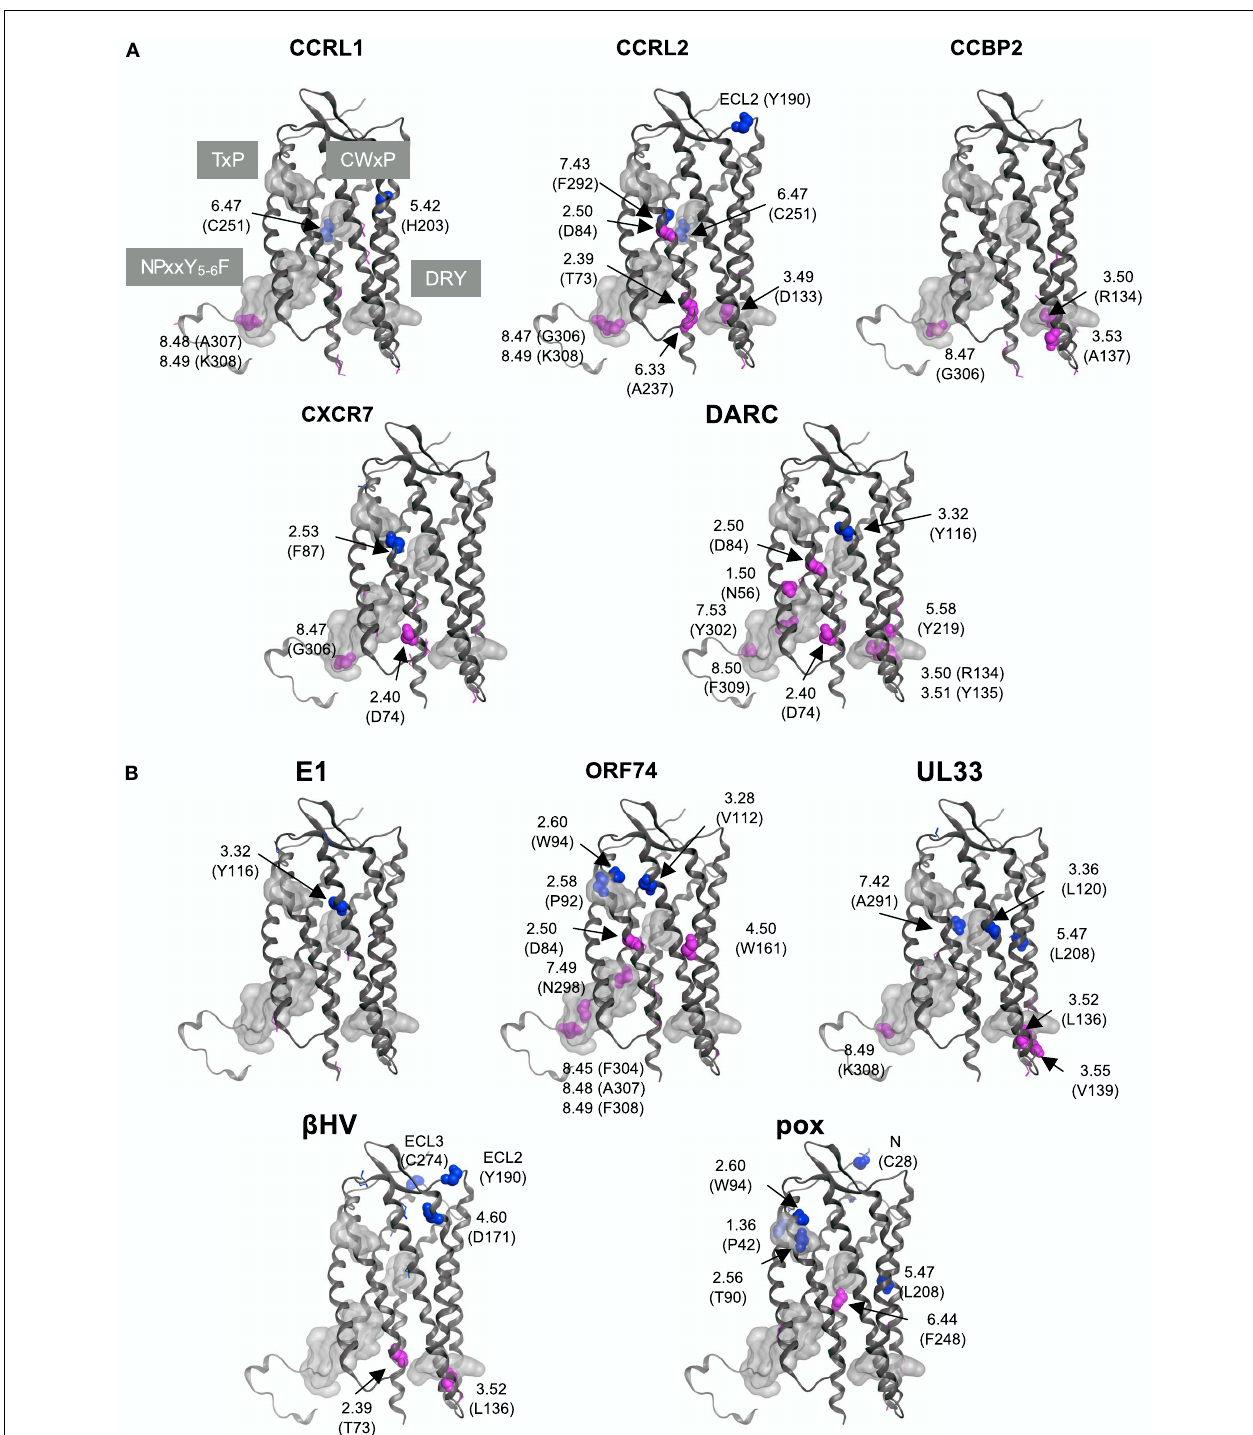
nomenclature.The corresponding amino acid residue types and numbers of CXCR4 are also shown in parentheses. On the other hand, the sites without any information are indicated by line models.The four motif regions are indicated by gray surface models.The residues that mapped on the extracellular side are colored blue, and those that mapped on the intracellular side are colored